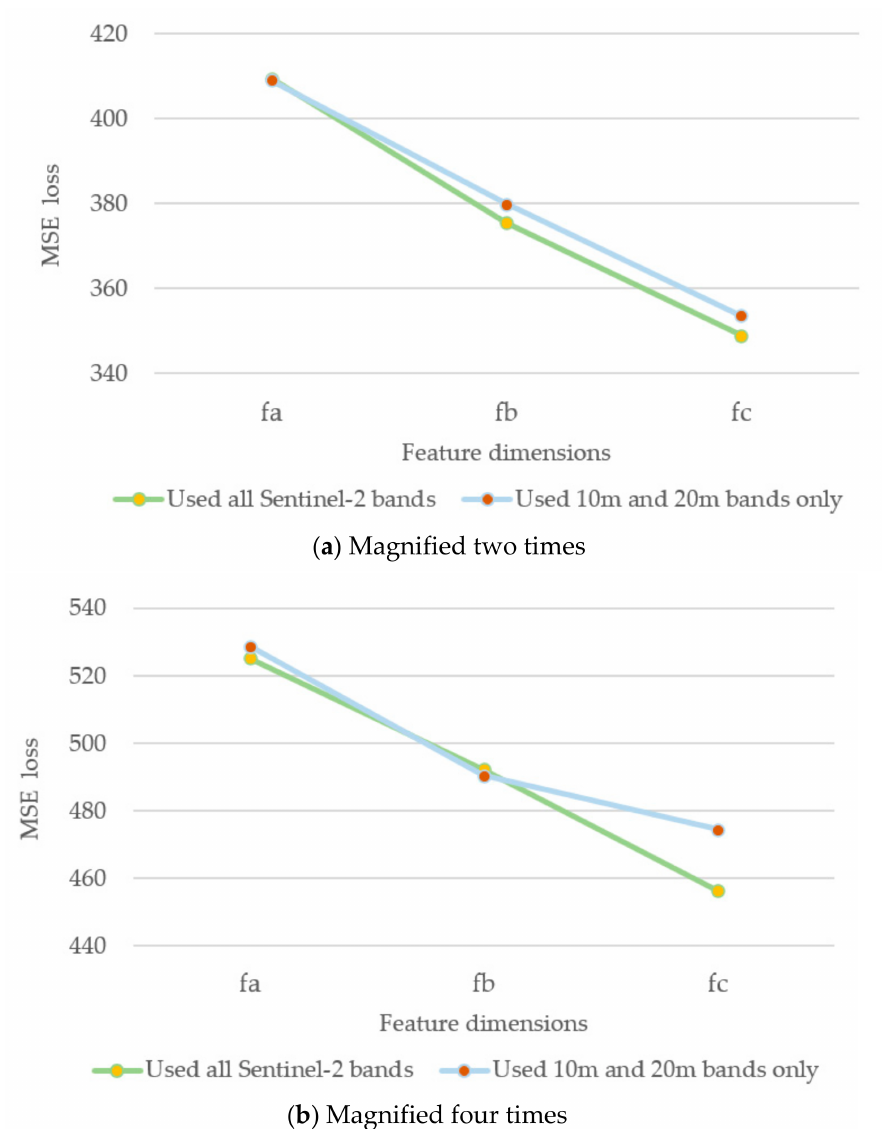
Figure 7. Convergence results according to each feature dimension.